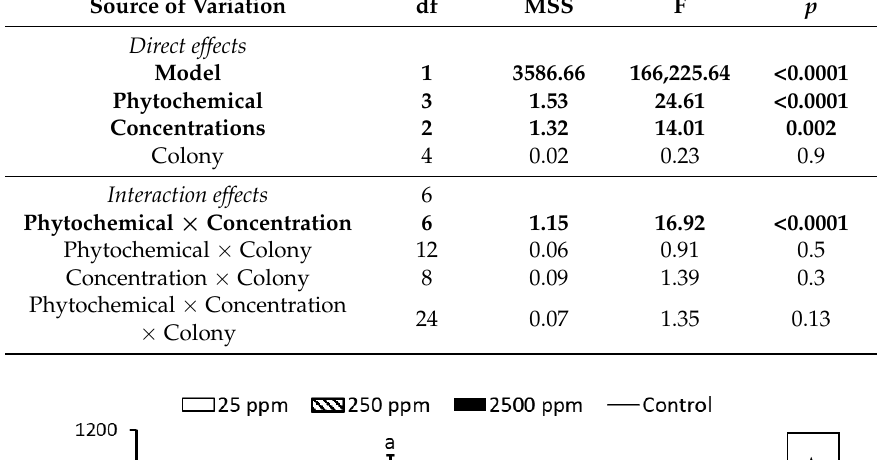
Table 2. GLM Univariate analysis of N. ceranae spore load in worker bees with dietary supplementation of phytochemicals at different concentrations. Bold cells indicate significance.